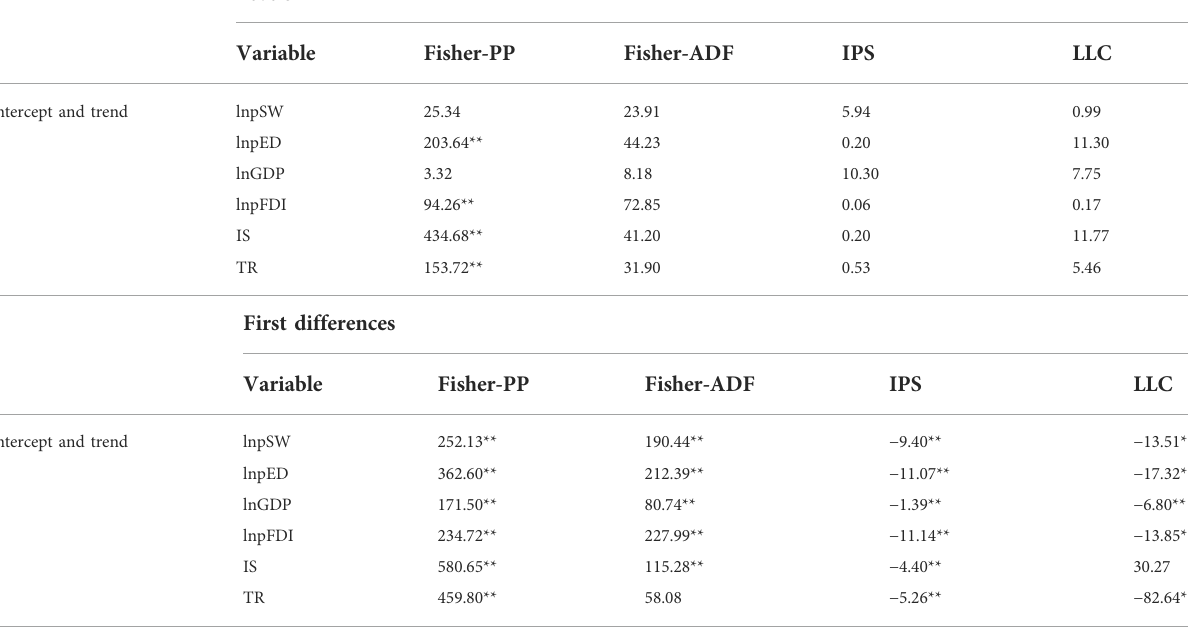
TABLE 6 Results from panel unit root test.